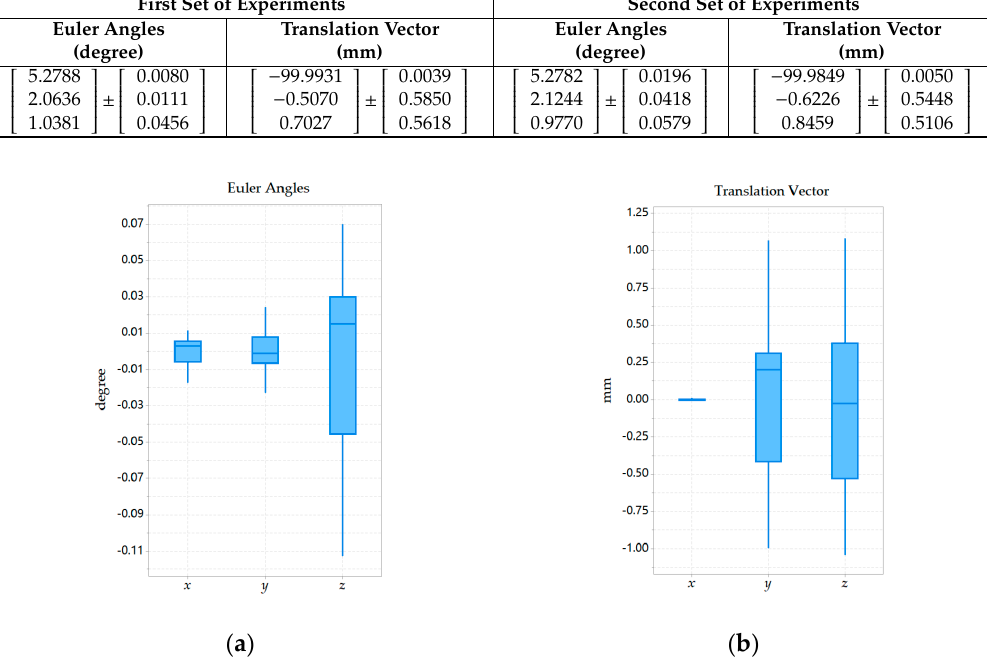
Table 2. The mean and standard deviation of Euler angles and translation vectors.